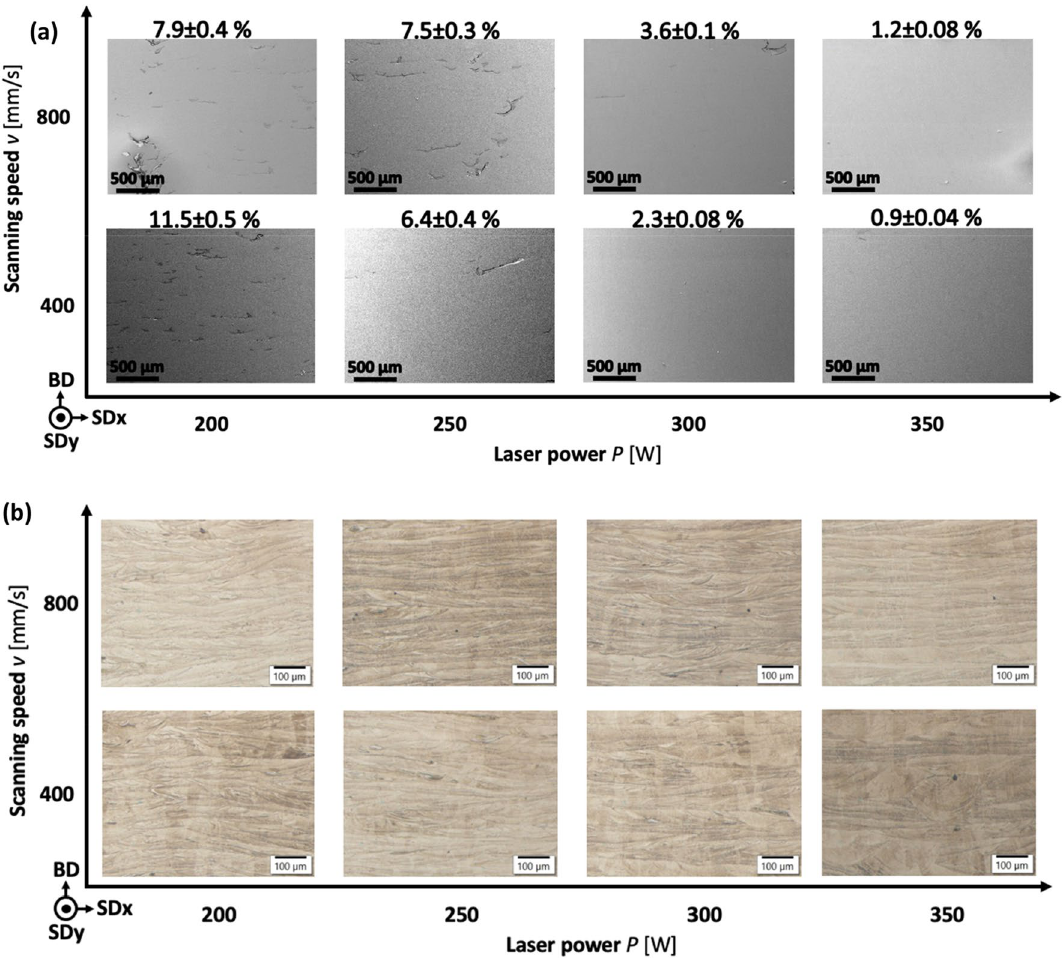
Figure 1. SE ( a ) and LM ( b ) images of the samples with the amount of defects (porosity, oxides and